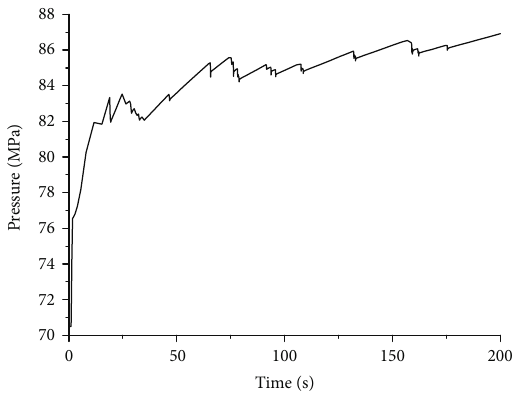
Figure 26: Pressure curve at the NF approaching angle of 45 ° and stress anisotropy coe ffi cient of 0.1.